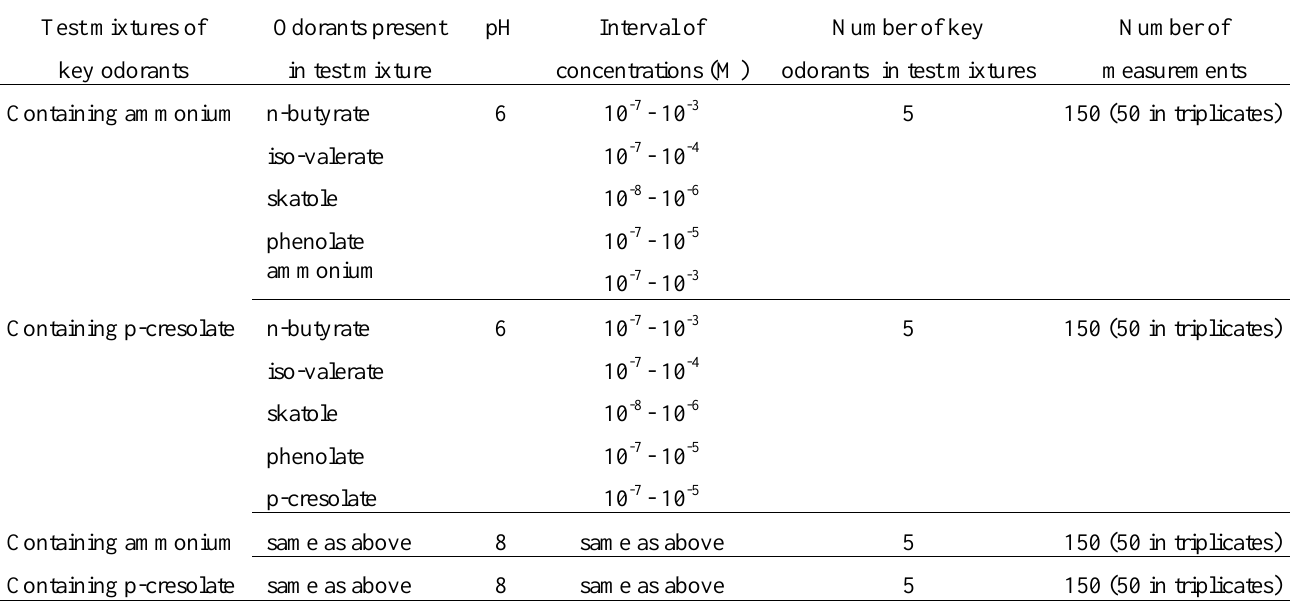
Table 1. Test mixtures of key odorants in four groups of experiments. Test mixtures